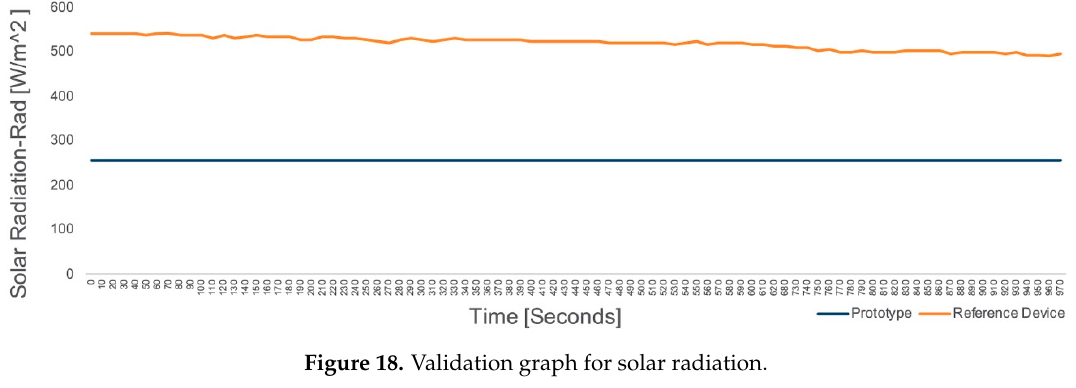
Figure 17. The linear regression graph for wind speed.